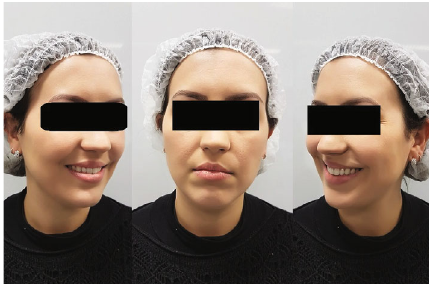
Figure 1: The clinical exam con fi rmed the face rounded and the indication for Bichectomy technique.